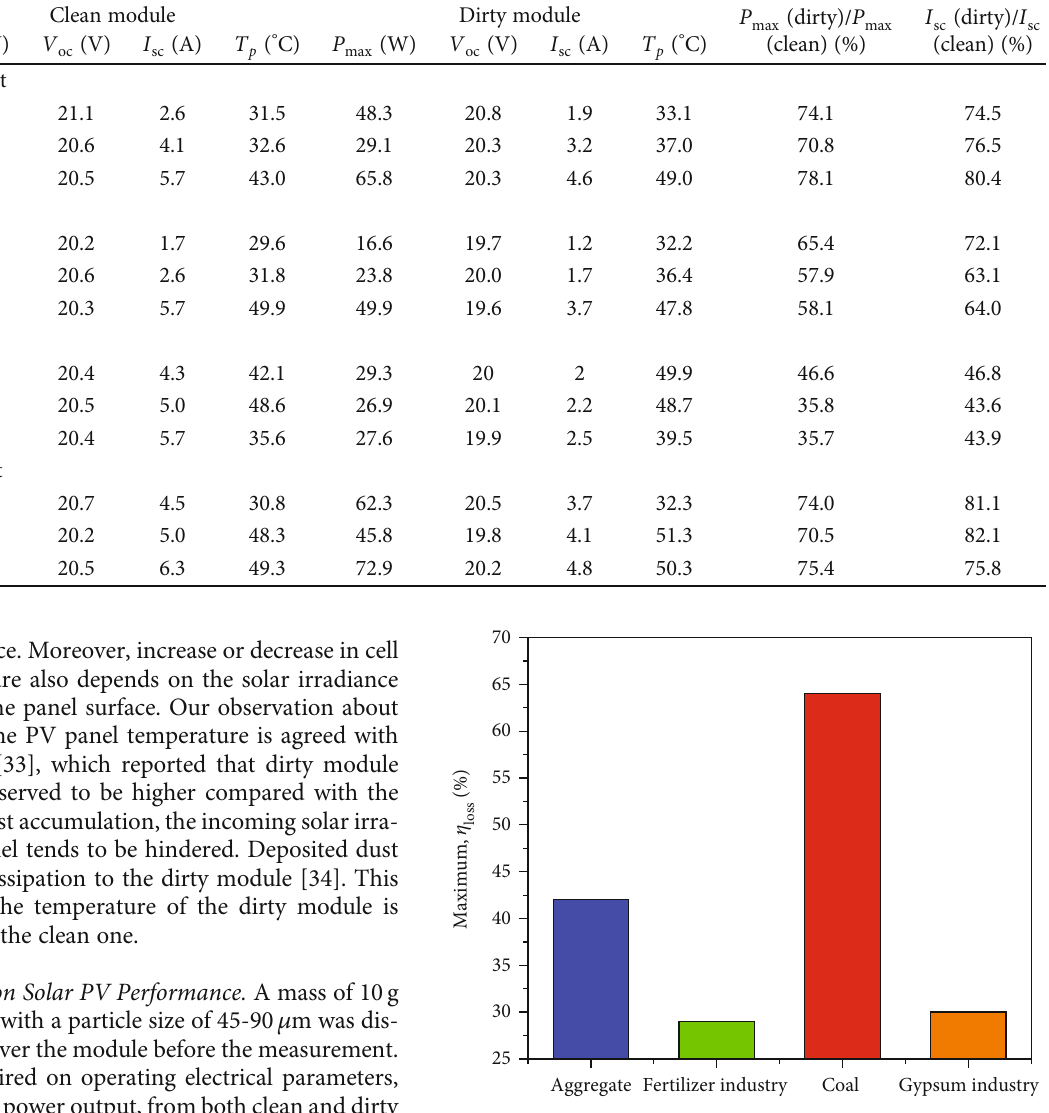
G (W/m 2 ) Clean module